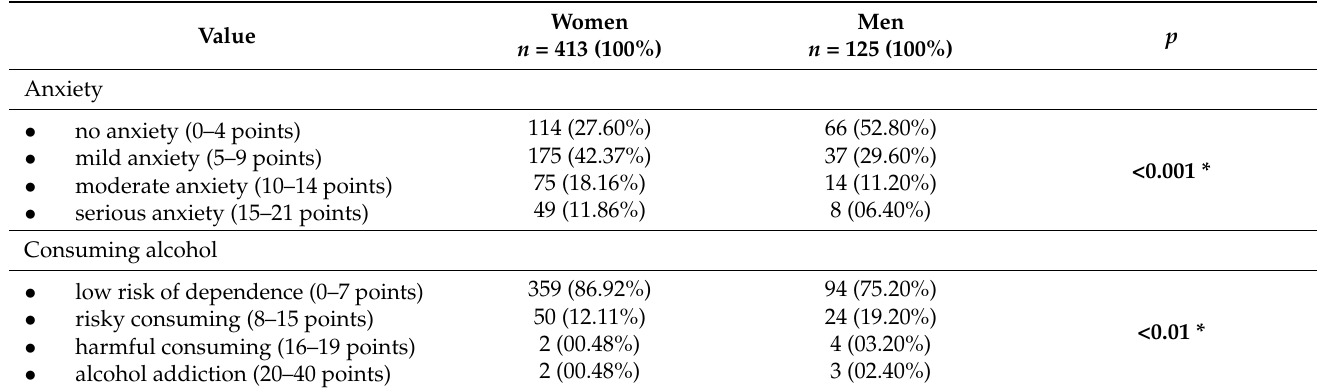
Table 3. Statistical differences between the study groups divided by sex in terms of anxiety and the level of alcohol consumption after obtaining normalized